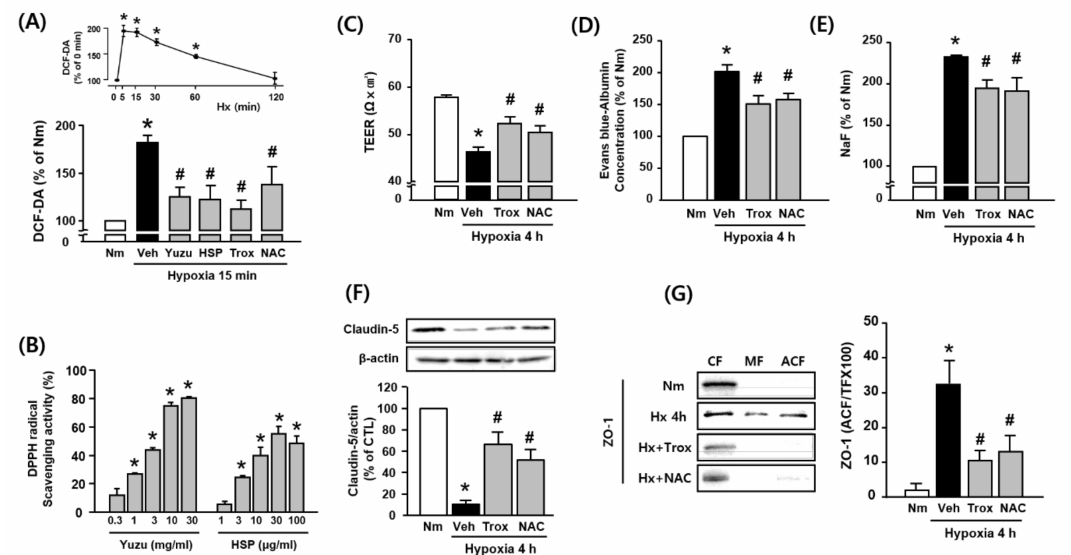
Figure 4. Protective e ff ects of yuzu and hSP on the disruption of claudin-5 and ZO-1 are associated with antioxidant activity during hypoxia in bEnd.3 cells. ( A ) ROS generation during hypoxia was quantified by pretreating the cells with yuzu, hSP, Trolox, or NAC. ROS levels in the cells were quantified by measuring DCF-DA (2 (cid:48) 7 (cid:48) -dichlorofluorescein diacetate) fluorescence intensity and are represented as the percentage (%) intensity at 0 min. ( B ) DPPH radical scavenging activity of yuzu and hSP in vitro. * p < 0.05 vs. negative control (methanol alone). ( C – E ) Quantitative analysis of ( C ) TEER, ( D ) Evans blue–albumin concentration, and ( E ) NaF in the bEnd.3 cell monolayer, as measured 4 h after hypoxia. All cells were pretreated with 100 µ m Trolox and 100 µ m NAC 30 min before hypoxia. ( F , G ) Western blotting of claudin-5 and ZO-1 in the absence or presence of Trolox or NAC during 4 h of hypoxia. Data are shown as mean ± SEM ( n = 5–7). * p < 0.05 vs. nm. # p < 0.01 vs. Veh. nm, normoxia; Veh, vehicle; ROS: hydrogen peroxide; hx, hypoxia; hSP, hesperidin; CF, cytosolic fraction; MF, membrane fraction; ACF, actin cytoskeleton fraction; Trox,